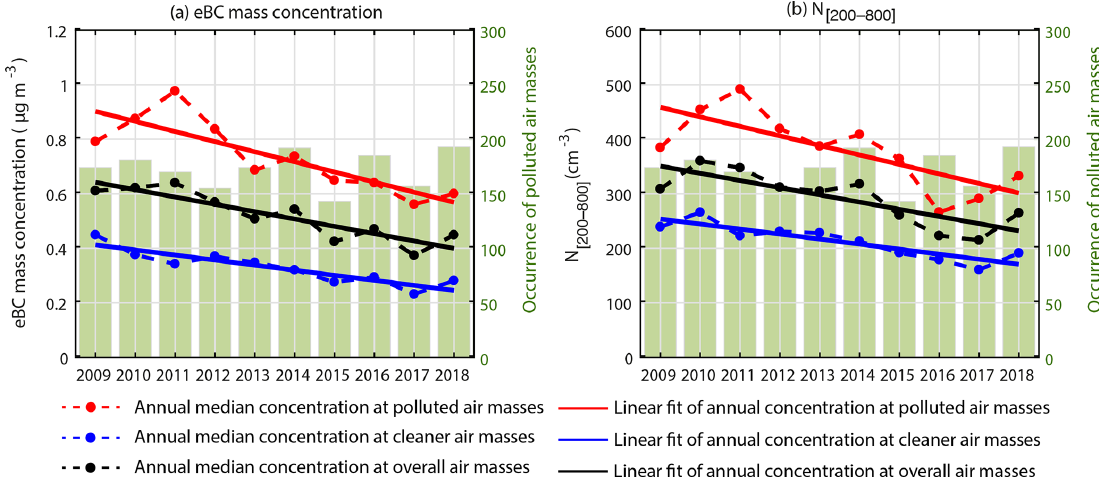
Figure 10. Annual average eBC mass concentration and N [ 200 − 800 ] measured at the regional background and low mountain range sites for the polluted and clean air mass categories. Green bars show the frequency of polluted air masses in each